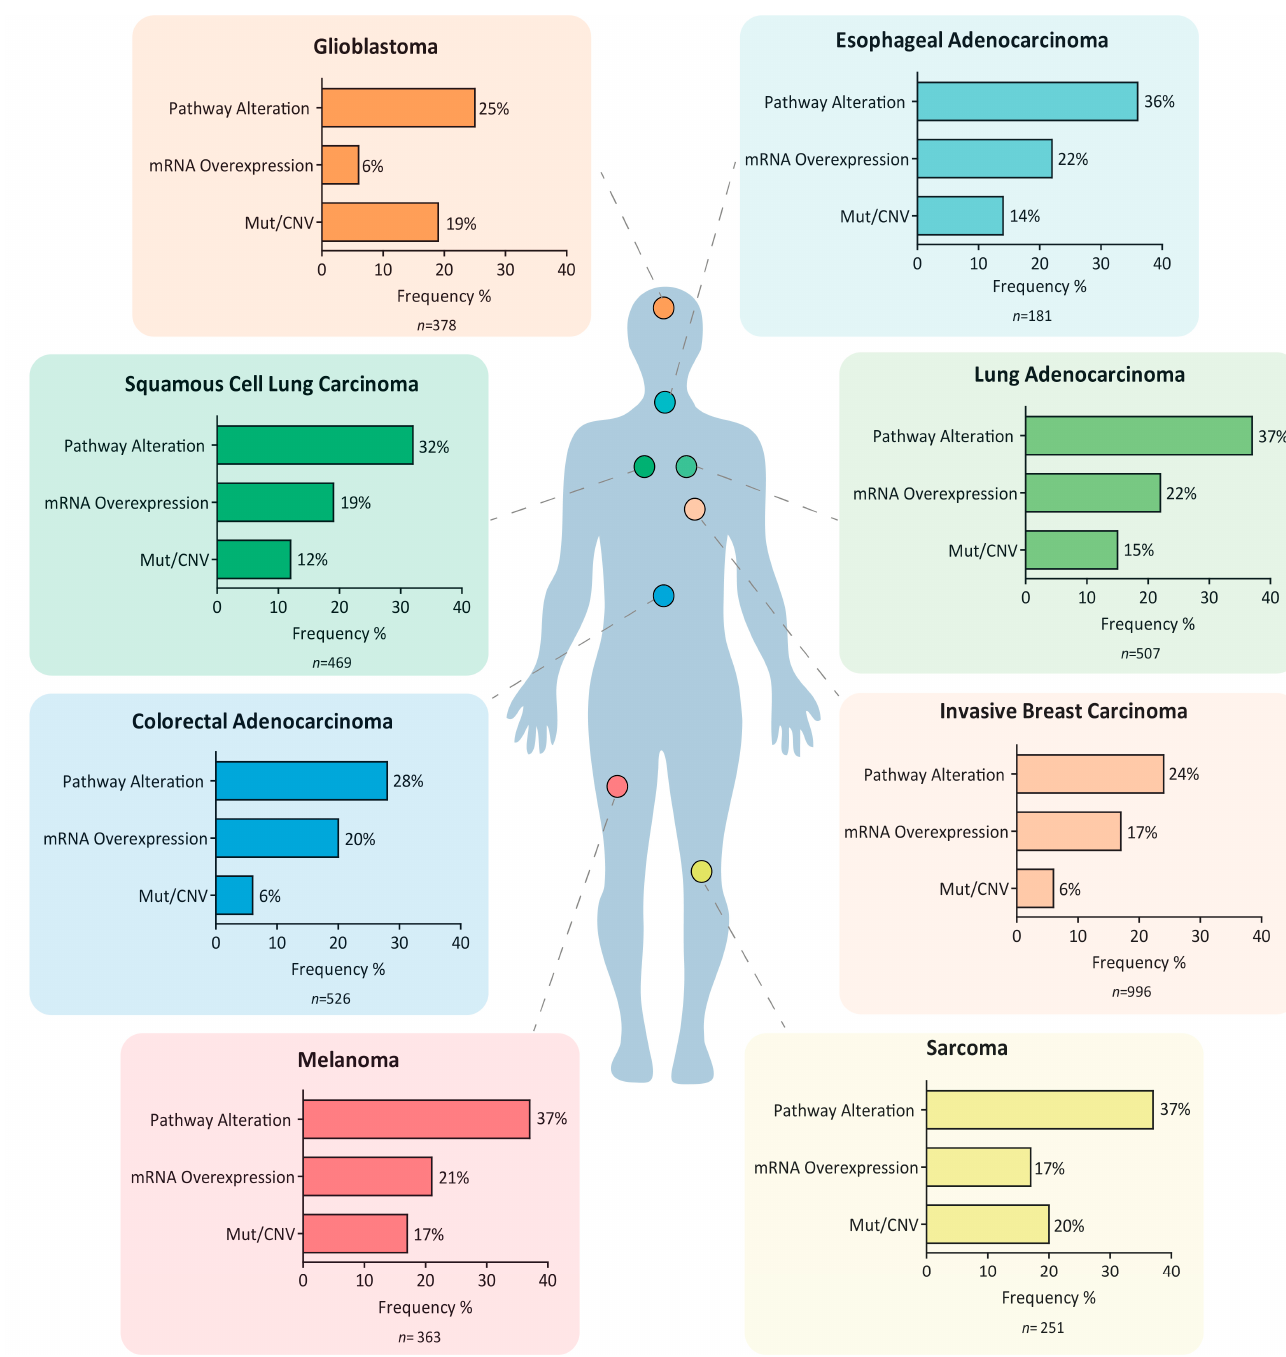
Figure 2. Serine/glycine biosynthesis pathway hyperactivation signatures in cancer. Representation of the frequency of distinct alterations in serine/glycine biosynthesis genes, i.e., PHGDH , PSAT1 , PSPH , SHMT1 , and SHMT2 , across a set of patients for different cancer types. These alterations include mRNA overexpression, somatic mutations, and copy number gain/amplification, which can be associated with serine/glycine biosynthesis pathway hyperactivation signature. The graphs also show the frequencies of mRNA overexpression and mutations/copy number variations separately in each case. This data was collected from the The Cancer Genomic Atlas (TCGA) PanCancer Atlas datasets in cBioPortal.org